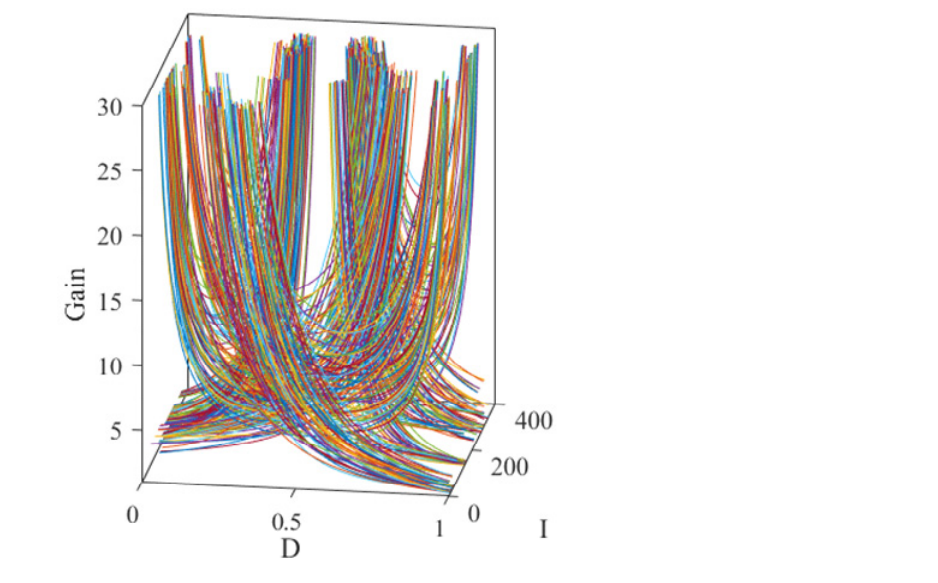
Figure 3. All possible gain curves that must have a boost capability in the duty cycle range of 0 < D < 1. Table 3. Obtained topologies for four different voltage gains.